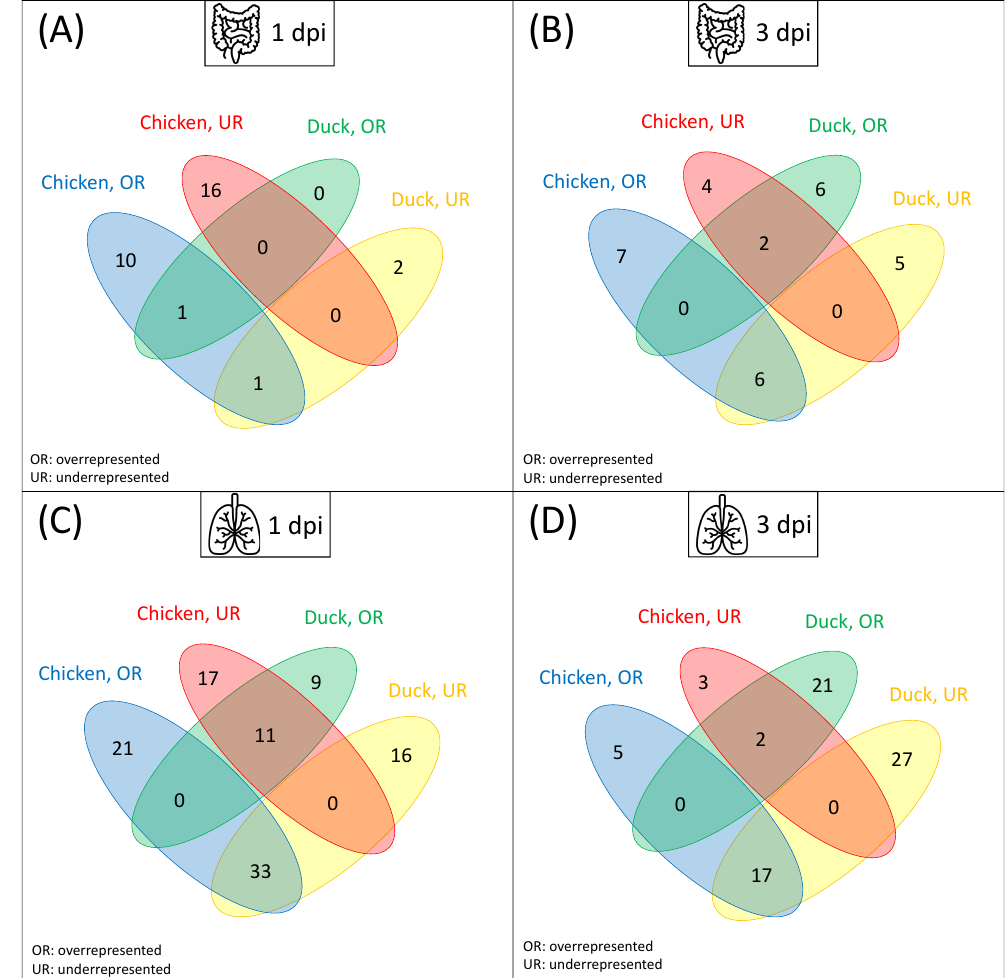
Figure 3. Venn diagrams of TFBS enrichment to compare over- (OR) and underrepresented (UR) binding sites in chicken and duck. The promoter regions of DEGs (after infection with HPAIV H5N1) in duck and the corresponding orthologous genes in chicken were extracted to obtain the over- and underrepresented TFBSs. ( A ) shows the corresponding number of TFBSs for the ileum 1 dpi, ( B ) shows the ileum 3 dpi, ( C ) shows the lung 1 dpi and ( D ) shows the lung 3 dpi. Venn diagrams are based on the data provided in Table